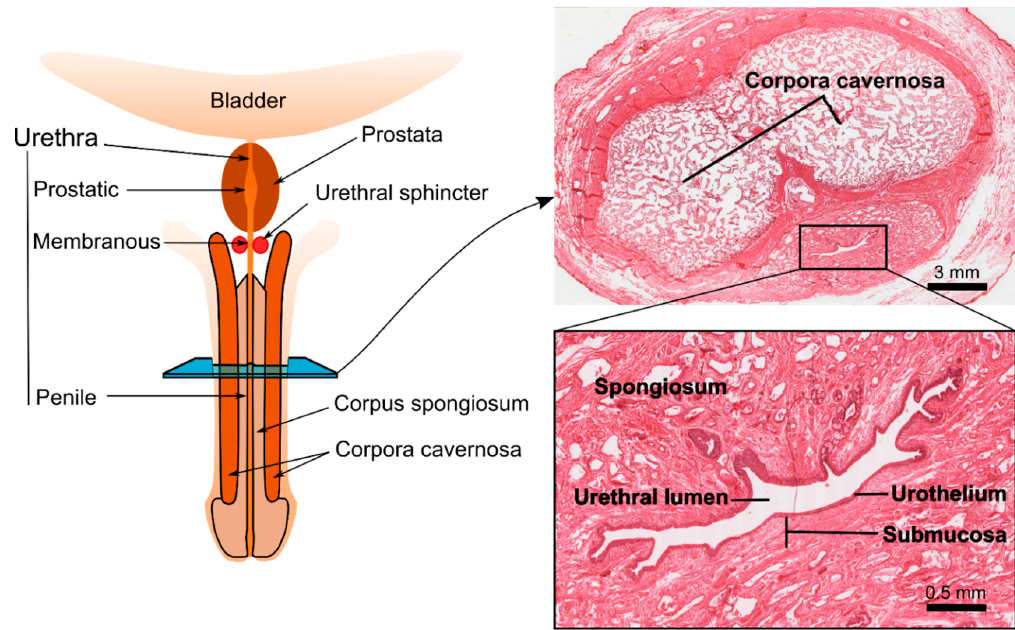
Figure 1. Diagram showing the general anatomical features of the human penis with a cross section at the level of the penile urethra showing the different anatomical structures. The histological examination at the level of the cross section shows the two corpora cavernosa and the urethra with its three main layers: epithelia, submucosa and spongiosum (histological images reprinted with permission from Ref. [25]). © 2019 Regents of the University of Michigan.